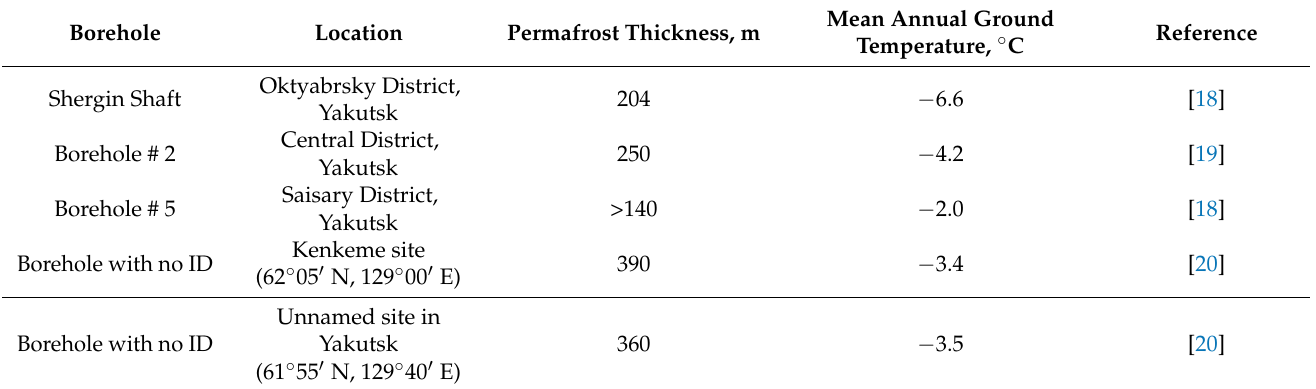
Table 1. Permafrost thickness and temperature for selected sites (based on materials from 1950–1960).